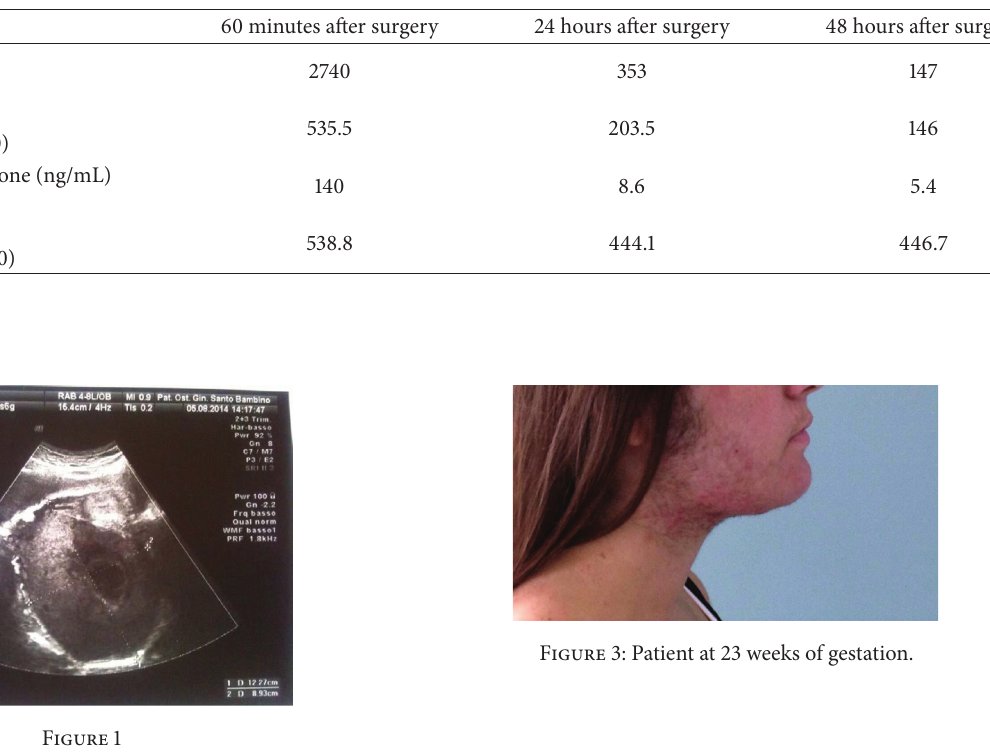
Table 1: Androgen levels after delivery.